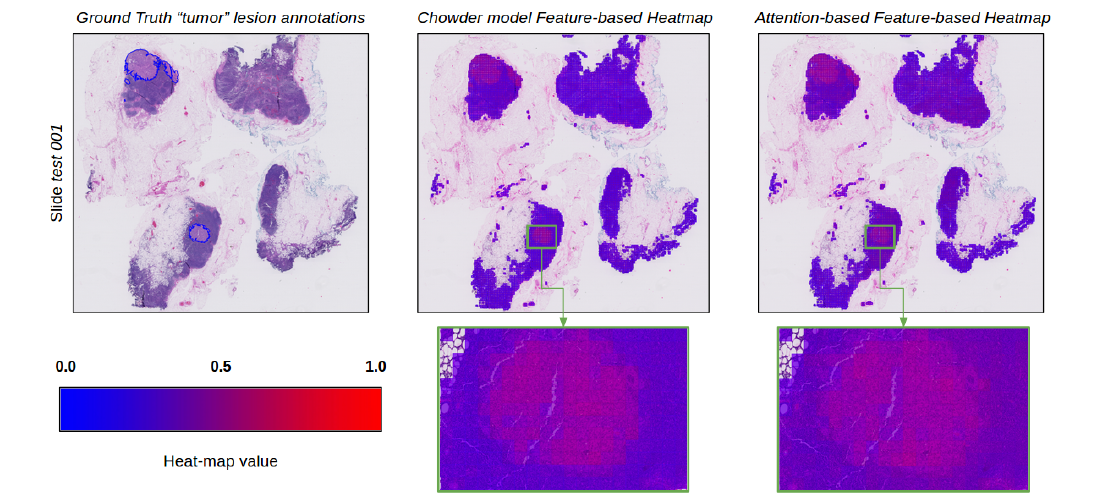
Figure 7. Slide-based visualizations: Heat-maps explaining the “tumor” class obtained by computing average normalized activation over identified features; ground-truth annotations for “tumor” tissue (left); CHOWDER model feature-based heat-maps (middle); attention-based model feature-based heat-maps (right). Table 1. Results: classification and localization AUC using both methods (improvement of localiza-